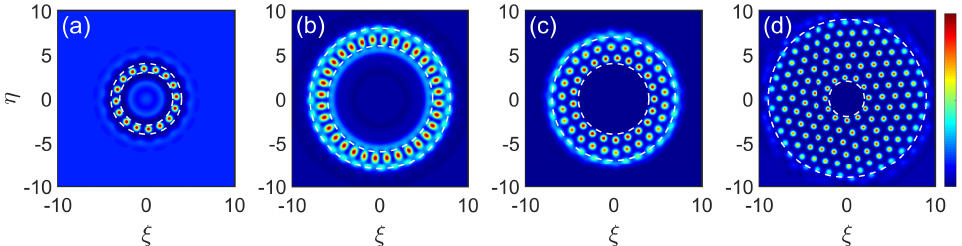
Figure 6. Pattern formation in ring structure potentials. From panel ( a – d ), the ring-shaped shape patterns as functions the dimensionless coordinate ξ and η with σ = 0.6 for different parameters a and b which are, respectively: ( a ) a = 3, b = 4; ( b ) a = 6, b = 8; ( c ) a = 4, b = 7; and ( d ) a = 2, b = 9. All data are normalized into 1, and all figures share the same color